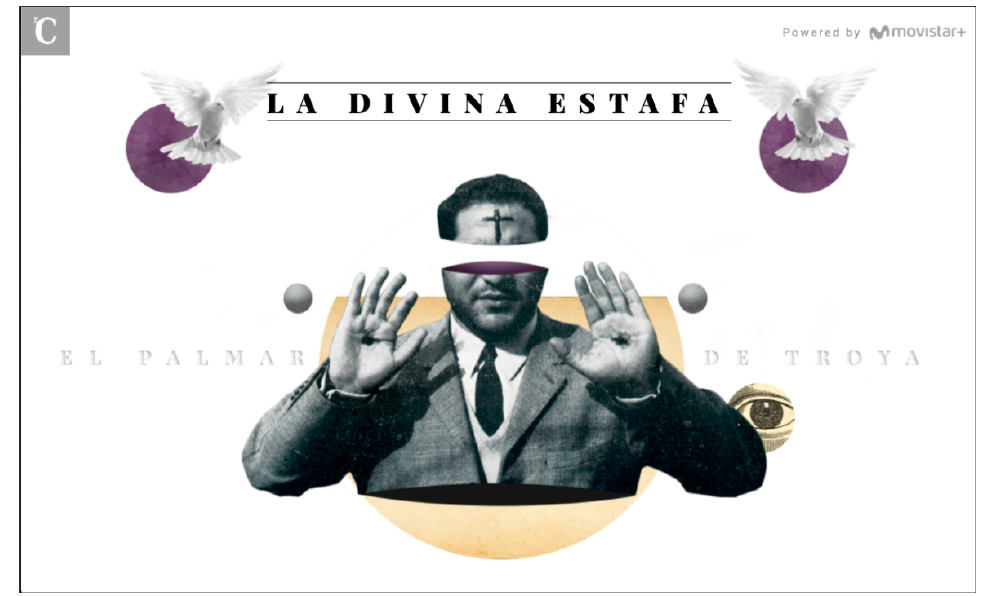
Figure 3. Native advertising action via the webdocs format for Movistar’s documentary series, El Confidencial.